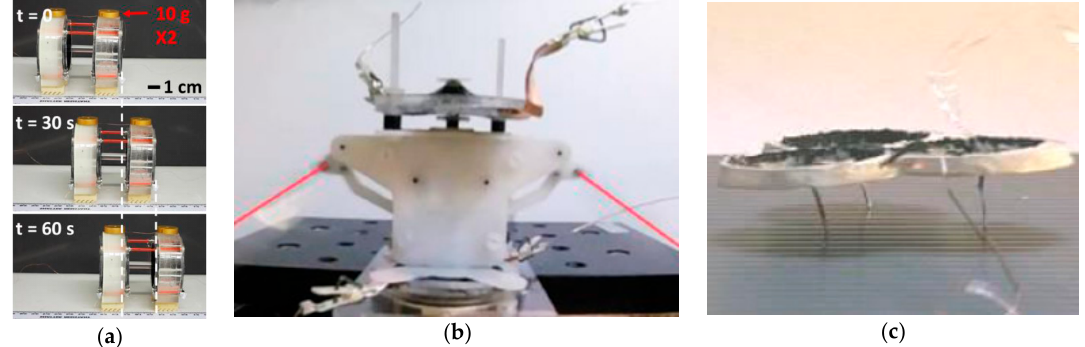
Figure 10. DEA driven crawling robot, flapping robot and jumping robot: ( a ) Crawling robot [106]; ( b ) Flapping robot [108]; ( c ) Jumping robot [110].